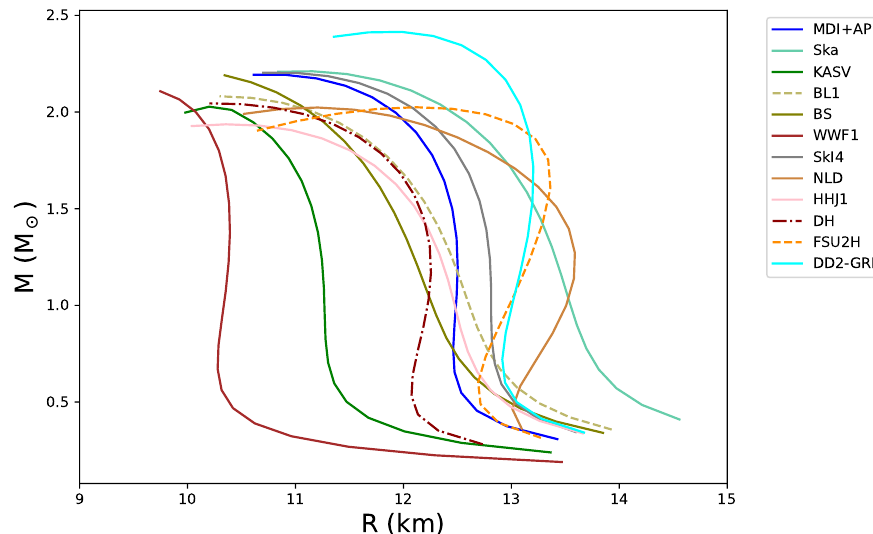
Figure 1. Mass–radius dependence for the employed cold EOSs.